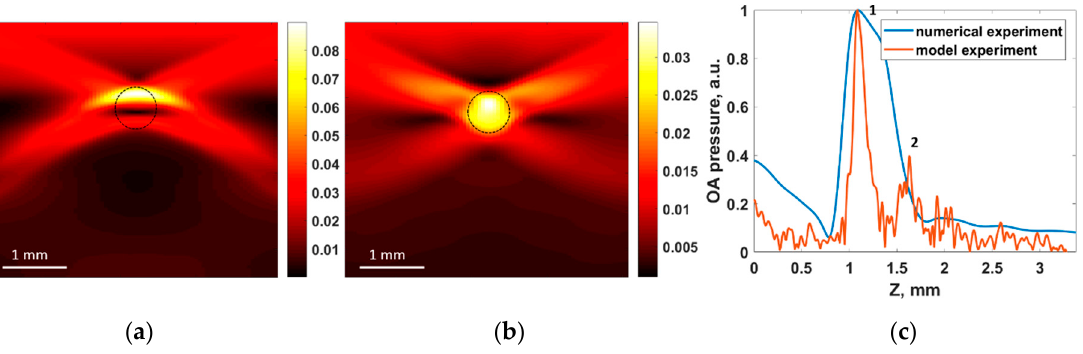
Figure 9. Numerical simulation of OA imaging of the BPD tube within the agar mixture phantom: ( a ) raw OA B-scan modeled in k-Wave (in kPa) and ( b ) reconstructed OA B-scan. Dashed black circle represents the actual cross-section of the BPD-containing tube. ( c ) Comparison of the simulated and experimentally registered OA signals.